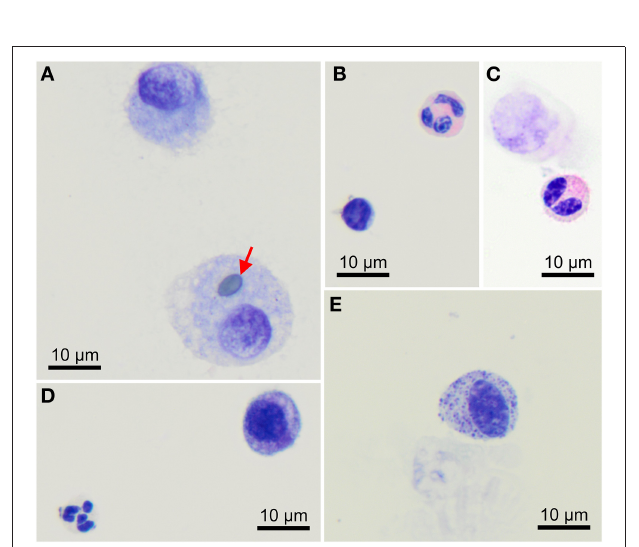
FIGURE 3 | Mucus observation in a bronchoalveolar lavage cytology from a healthy cynomolgus macaque. Low amount of mucus is admixed with nucleated cells and columnar epithelial cells. Modified Giemsa. X20